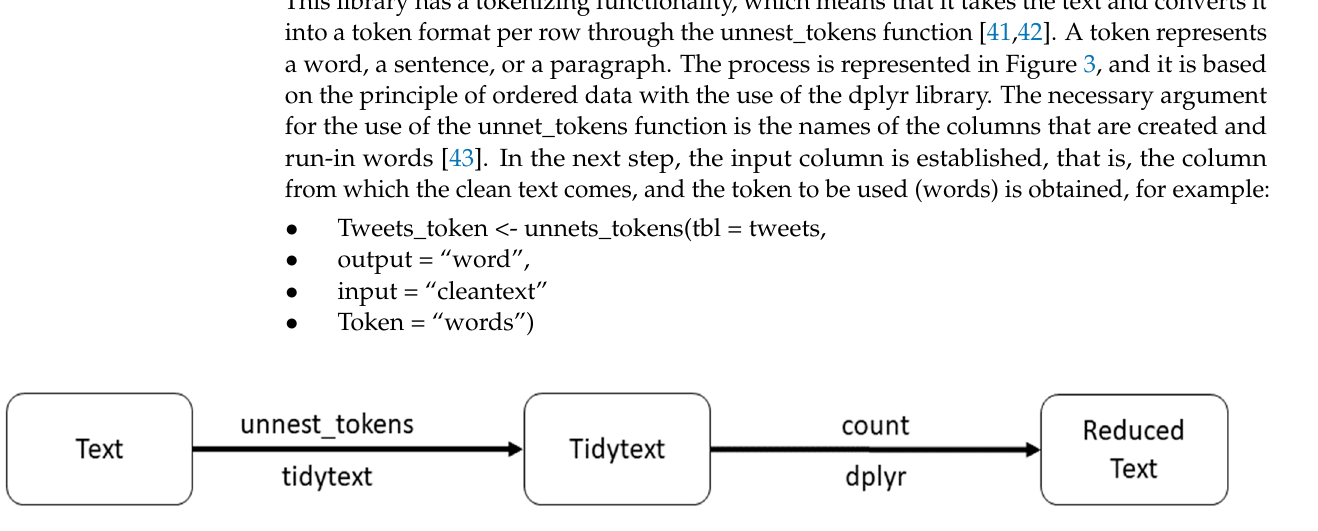
Figure 3. Applied process for Twitter sentiment analysis.